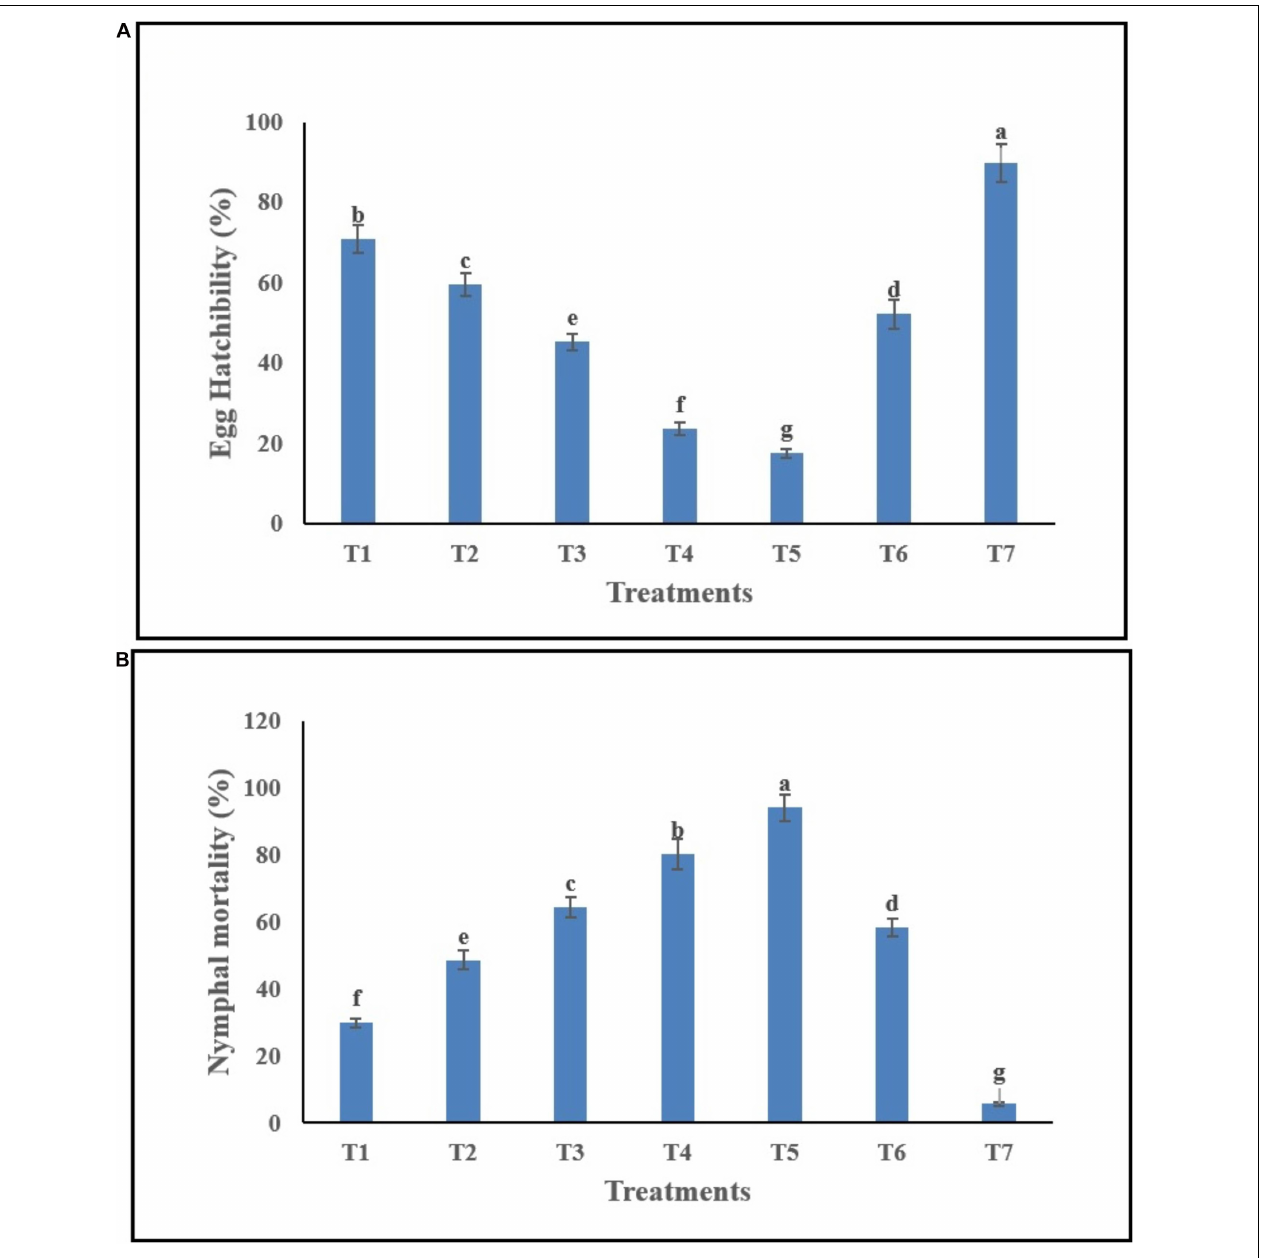
FIGURE 8 | Effects of C . fumosorosea -biochar nanoparticles on (A) egg hatchability and (B) nymphal mortality of B. tabaci. ∗ T1 = 5.0 ppm C . fumosorosea -biochar nanoparticles; T2 = 7.5 ppm C . fumosorosea -biochar nanoparticles; T3 = 10.0 ppm C . fumosorosea -biochar nanoparticles; T4 = 20.0 ppm C . fumosorosea